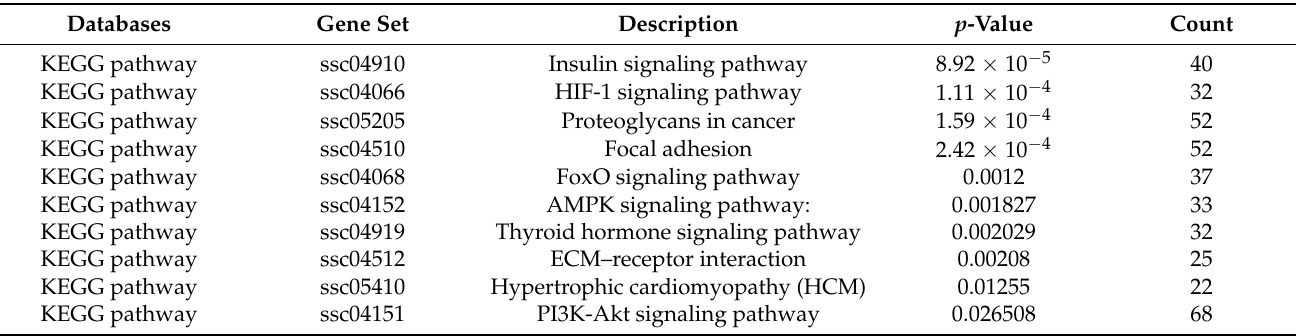
Table 9. KEGG pathway analysis of the maturation- and hypertrophy-related DEGs and proportional p -values identified in Sus scrofa .